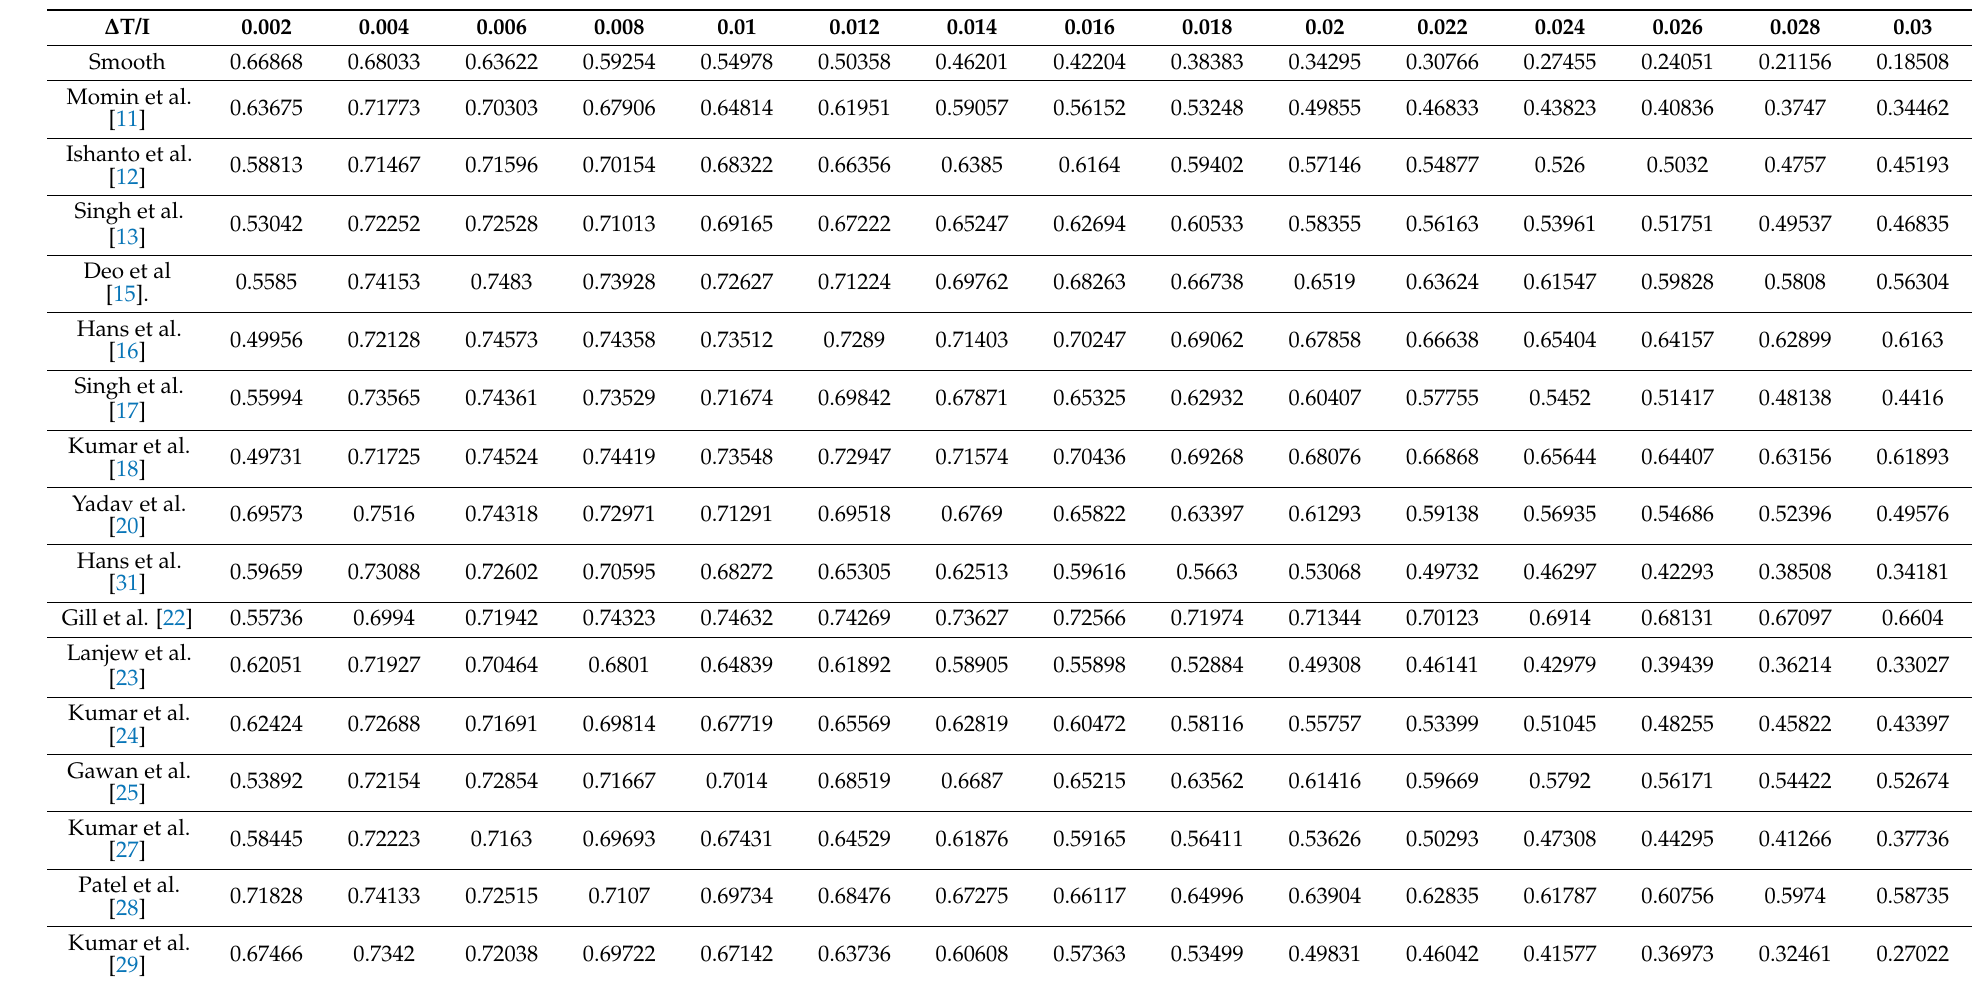
Table 3. Effective efficiency data at distinct value of ∆